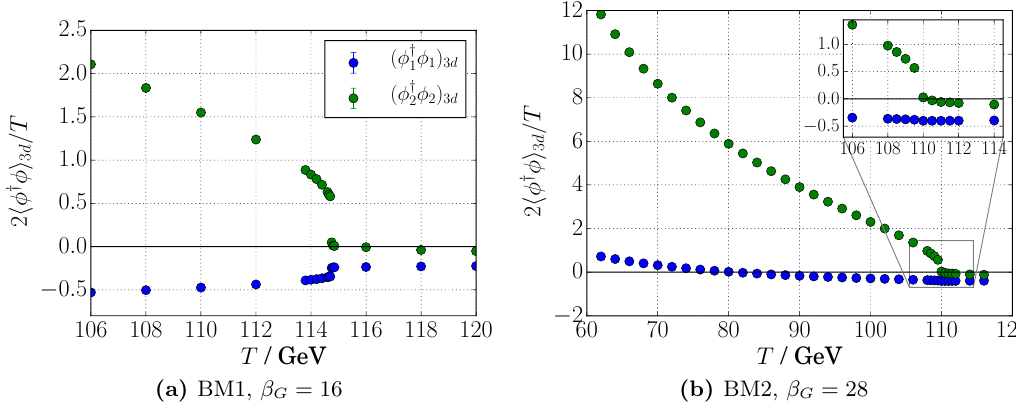
Figure 1. Gauge-invariant condensates of the two doublets as measured on the lattice with (cid:12)xed volume and (cid:12) G , converted to MS quantities using the relations in ref. [90]. In both cases, the doublet (cid:30) 1 is heavy and almost inert at the phase transition. Instead, its (cid:13)uctuations become more constrained as h (cid:30) y (cid:30) 2 i changes due to the (cid:21) 3 term in the action. In BM2, h (cid:30) y 2 towards its T = 0 value as governed by our choice of tan (cid:12)